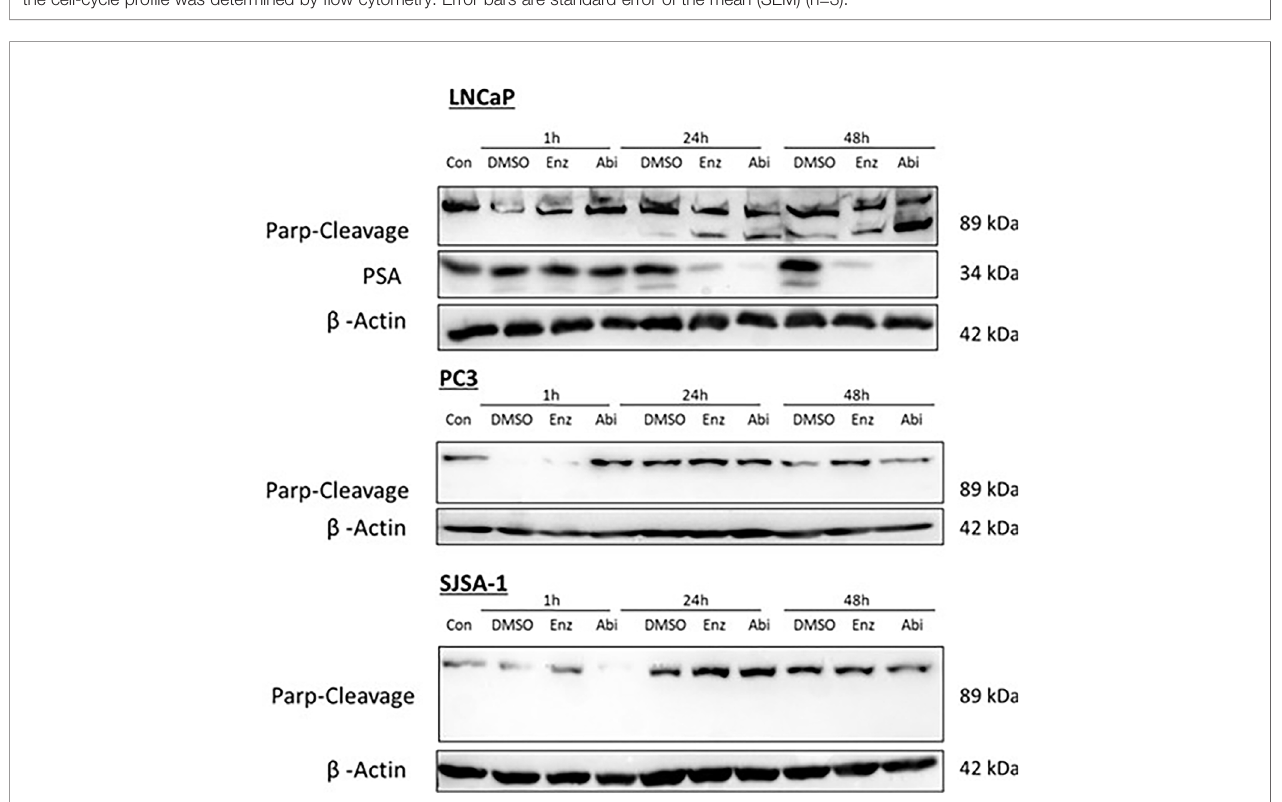
FIGURE 12 | Impact of Abiraterone and Enzalutamide on PARP cleavage in AR-insensitive PC3s, AR-sensitive LNCaP prostate models and osteoblastic bone model SJSA-1. Models were treated with 10 m M Abiraterone, Enzalutamide or DMSO. Samples were then harvested 1, 24 and 48 hours post-treatment and expression levels measured via Western blot. b -Actin was used as a loading control.